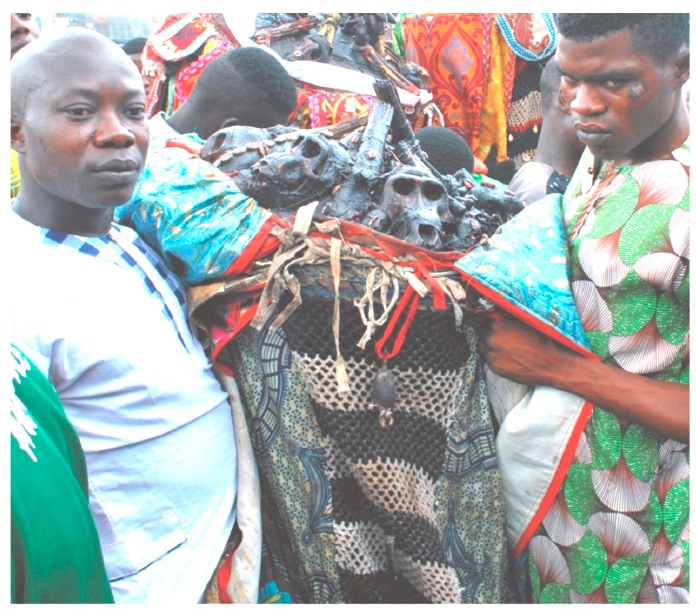
Figure 8. Close-up view of the erù ère (load of images) on the head of Egúngún Je ń jù. Source: Photograph by